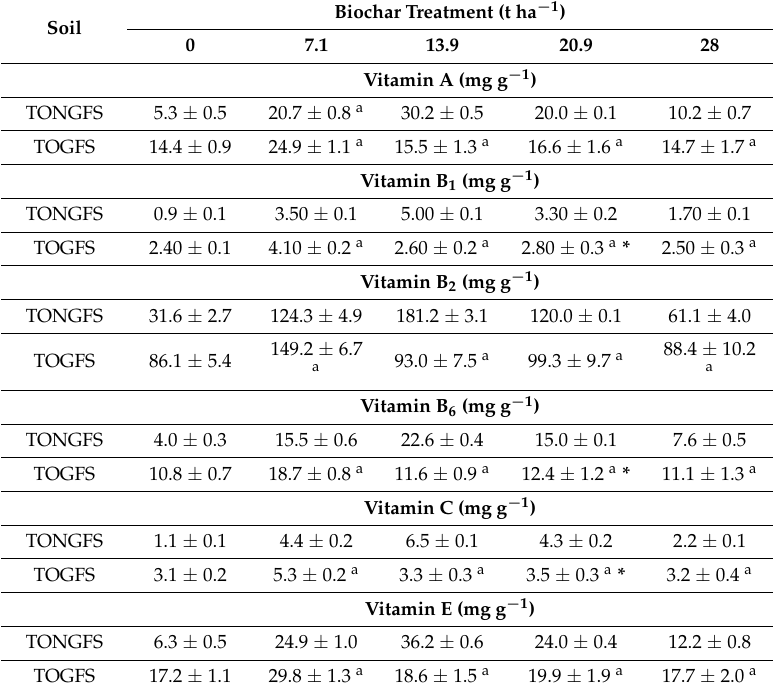
Table 3. Effects of different application rates of palm bunch biochar applied to sandy loam soil on the vitamin composition of T. occidentalis leaves cultivated on gas flared and non-gas flared